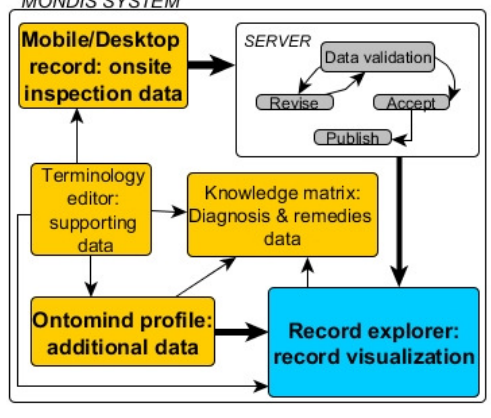
Figure 1. MONDIS system: